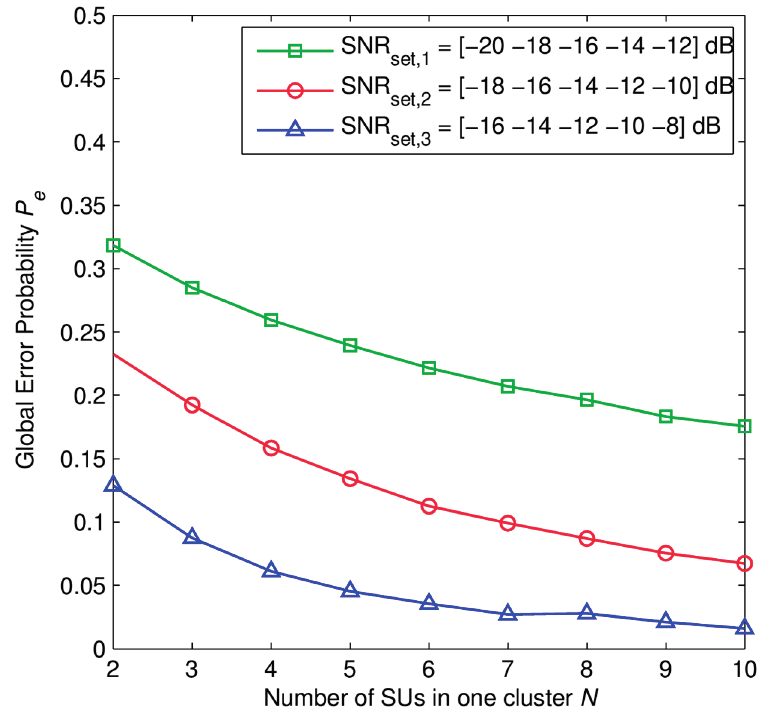
Figure 7. Global error probability P e as a function of number of SUs in one cluster N with P 1 = P 0 = 0.5, M = 50 samples, K = 5 clusters, SNR set , 1 = [ − 20 − 18 − 16 − 14 − 12] dB, SNR set , 2 = [ − 18 − 16 − 14 − 12 − 10] dB, SNR set , 3 = [ − 16 − 14 − 12 − 10 − 8]